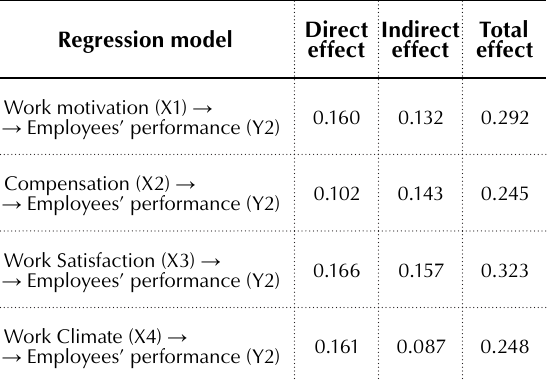
Table 3. Results of the tests on direct, indirect,